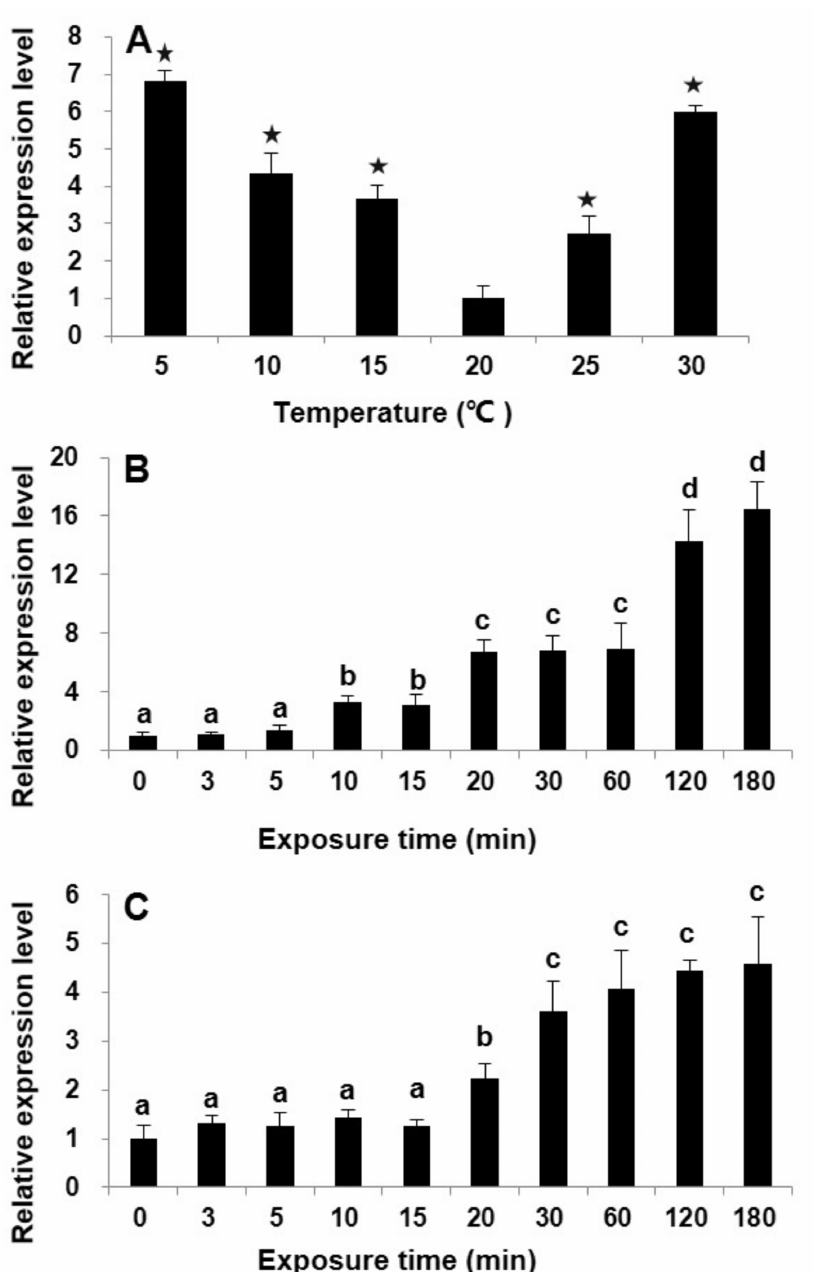
Figure 1. The transcription levels of StHsp90 in cells under different shock temperatures ( A ) and during a 180-min time course with a 30 ◦ C treatment ( B ) and 10 ◦ C exposure ( C ). Each bar represents the mean of three biological replicates, and error bars signify the standard deviation of those means. Asterisk indicates significant increases at the transcription level as compared with the 20 ◦ C group ( p < 0.05) ( A ). Same letter above the bar denotes no significant difference ( p > 0.05) in abundance ( B , C